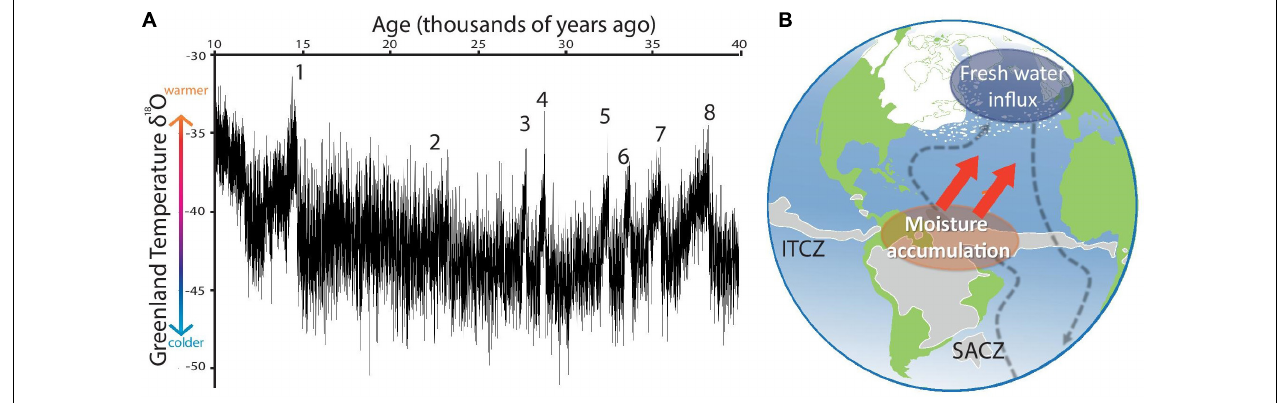
FIGURE 1 | (A) Greenland ice core record and abrupt climate events (DOs) over the last 40,000 years (Andersen et al., 2004, 2006; Svensson et al., 2006; Vinther et al., 2006; Gkinis et al., 2014). Numbers indicate the onset of the last 8 DO events. (B) Contrasting hypotheses of DO triggers. Dashed lines indicate the Atlantic Meridional Overturning Circulation. Solid lines represent the hypothesised atmospheric transport from the American tropics to the North